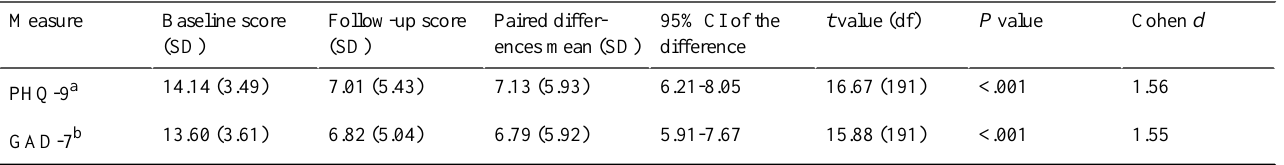
Table 7. Changes in depression and anxiety symptoms for participants starting at clinical levels of depression and anxiety symptoms